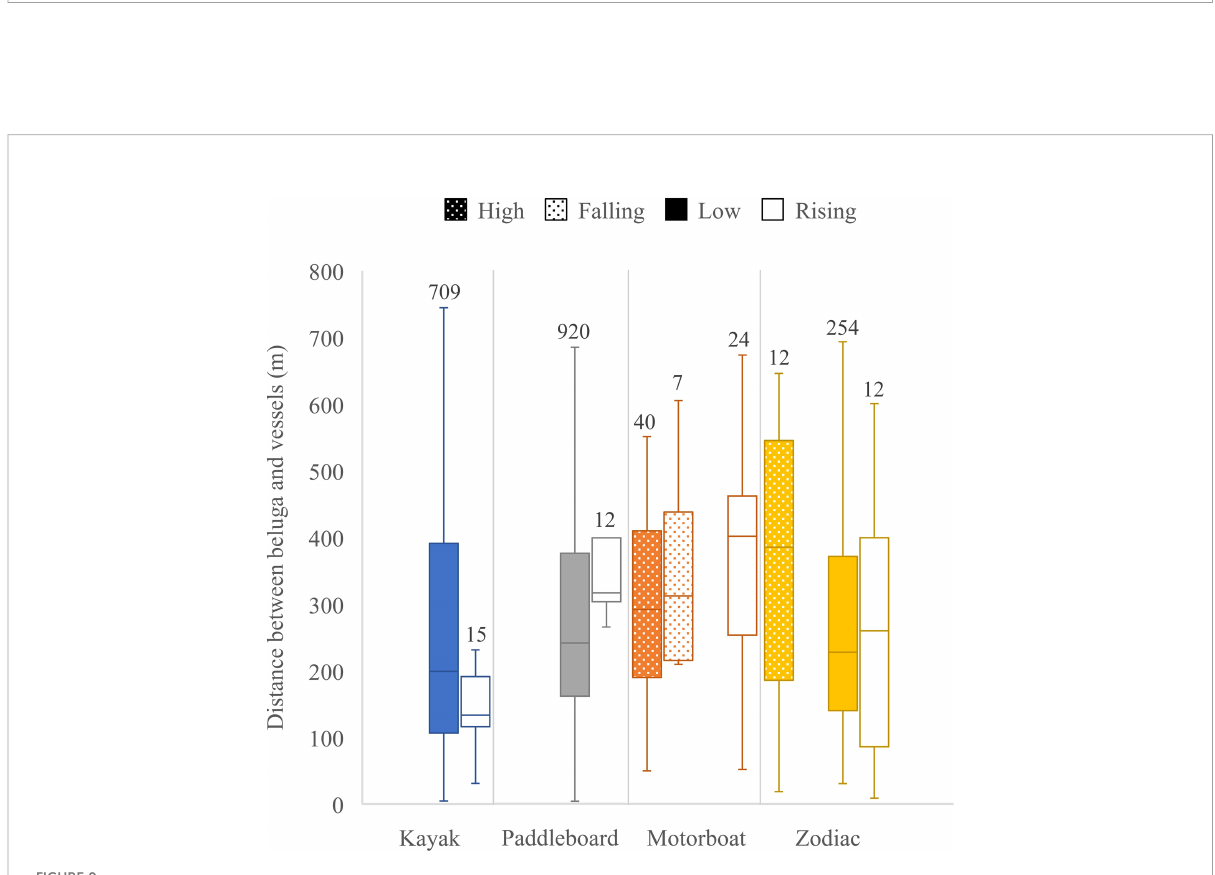
FIGURE 9 Distance between belugas and vessels by vessel type and tide. Quartiles calculated using inclusive median shown at edges of the box, center line of the box and ends of the tails. Sample sizes are given on top of each